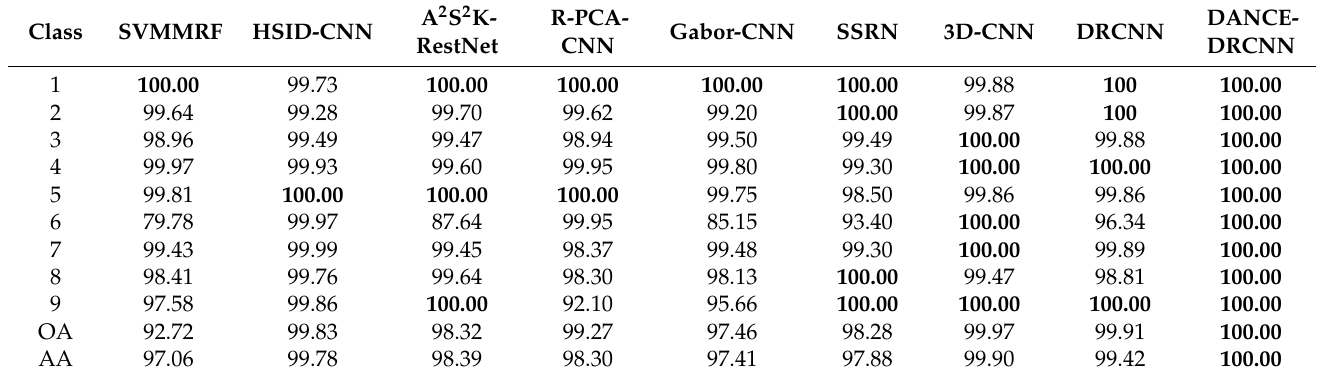
Table 6. Comparison of the classification accuracy (%) among the proposed method, DRCNN, and the baselines on the Salinas-small data.